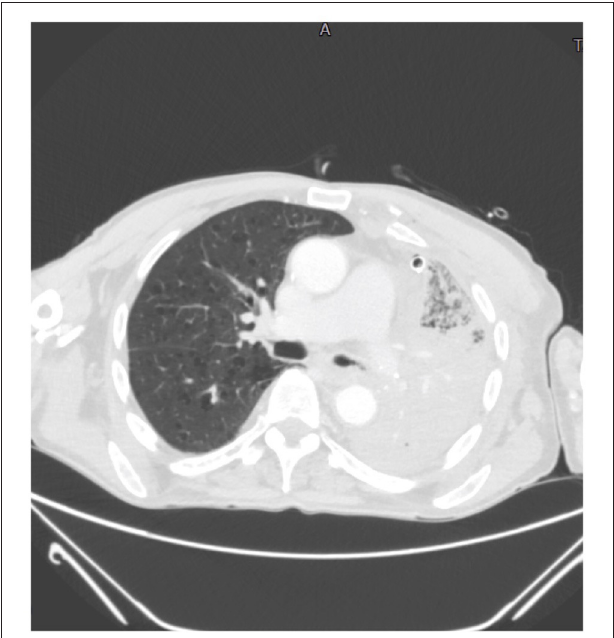
FIGURE 5 | An almost complete recovery revealed by a new chest CT